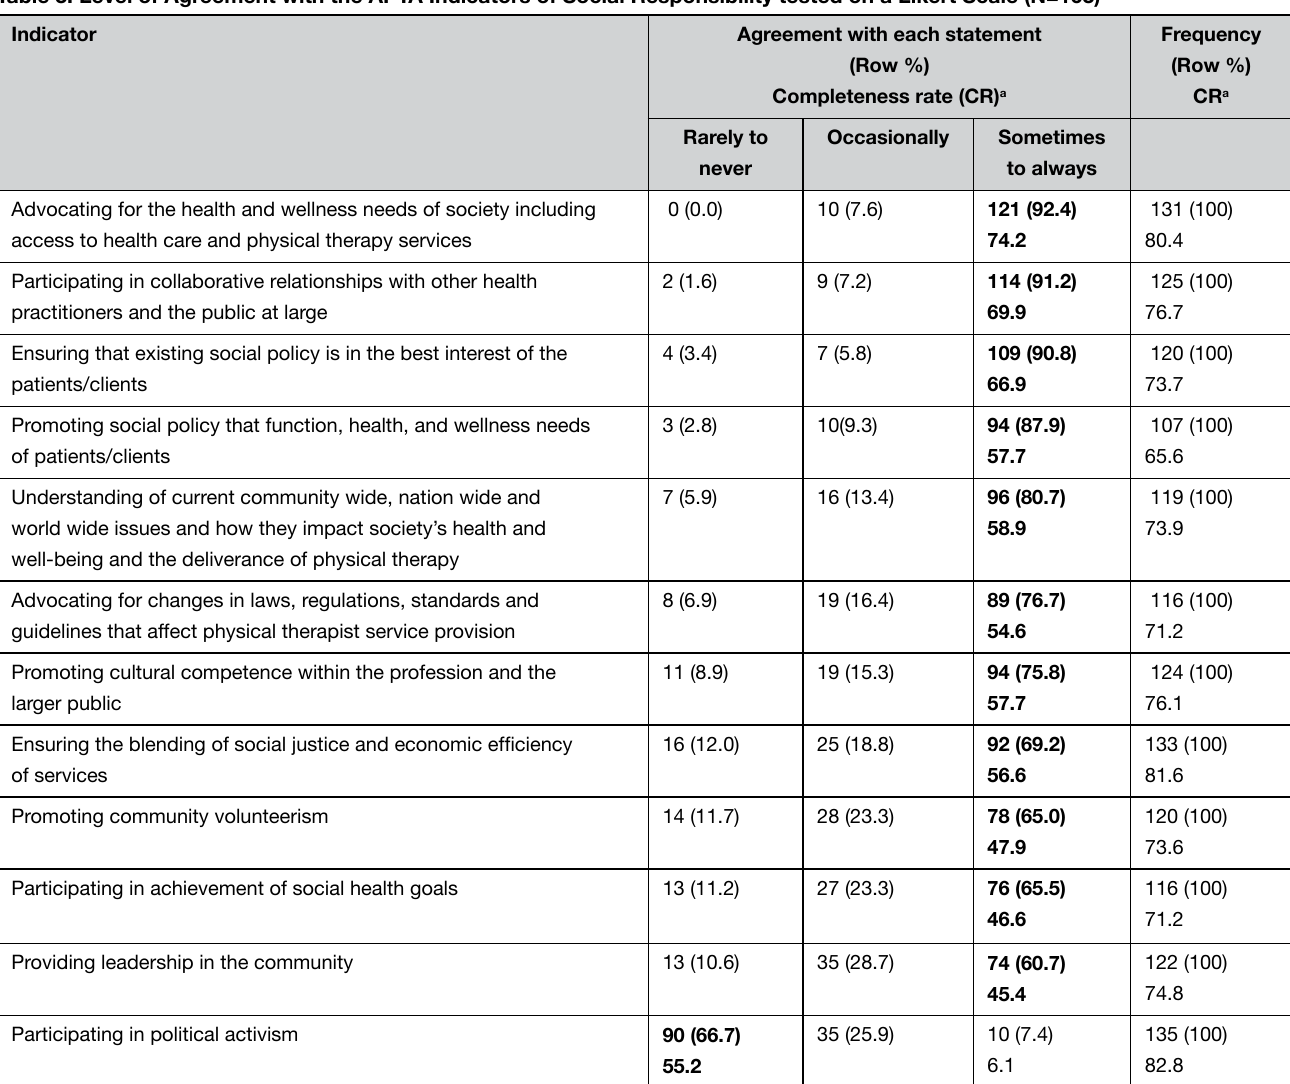
Table 3. Level of Agreement with the APTA Indicators of Social Responsibility tested on a Likert Scale (N=163) indicator